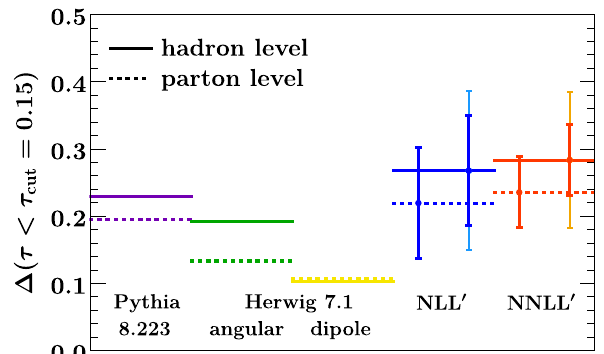
Fig. 1 The quark-gluon classifier separation (cid:2) for τ < 0 . 15 from Pythia 8.223 (violet), Herwig 7.1 angular-ordered shower (green) and dipole shower (yellow) compared to analytic resummation at NLL (cid:2) (blue)andNNLL (cid:2) (red).Theresultsatpartonandhadronlevelareshown in dotted and solid, respectively. The uncertainty bars on the resummed results show the perturbative uncertainty and also the sum of perturba- tive and hadronization uncertainties (lighter outer bars at hadron